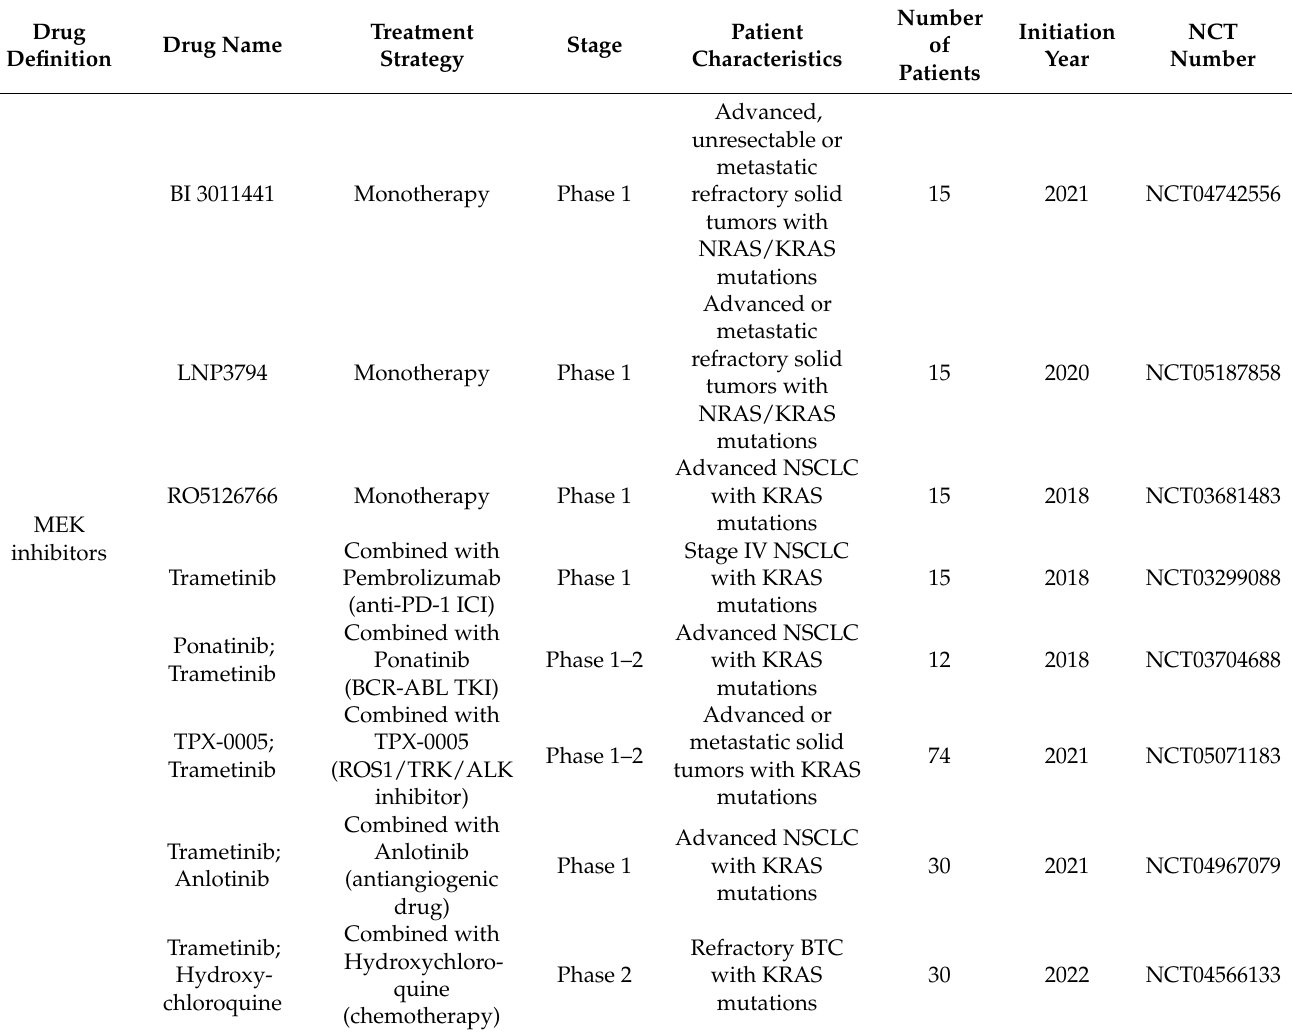
Table 3. Clinical Trials of Non-KRAS-Targeted Therapies on KRAS Mutant